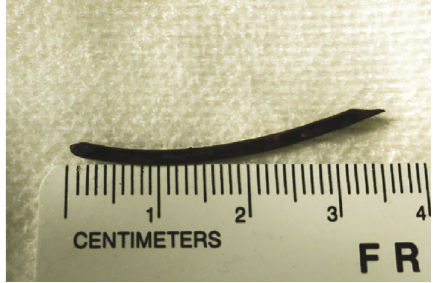
Figure 4: Extracted pediatric feeding